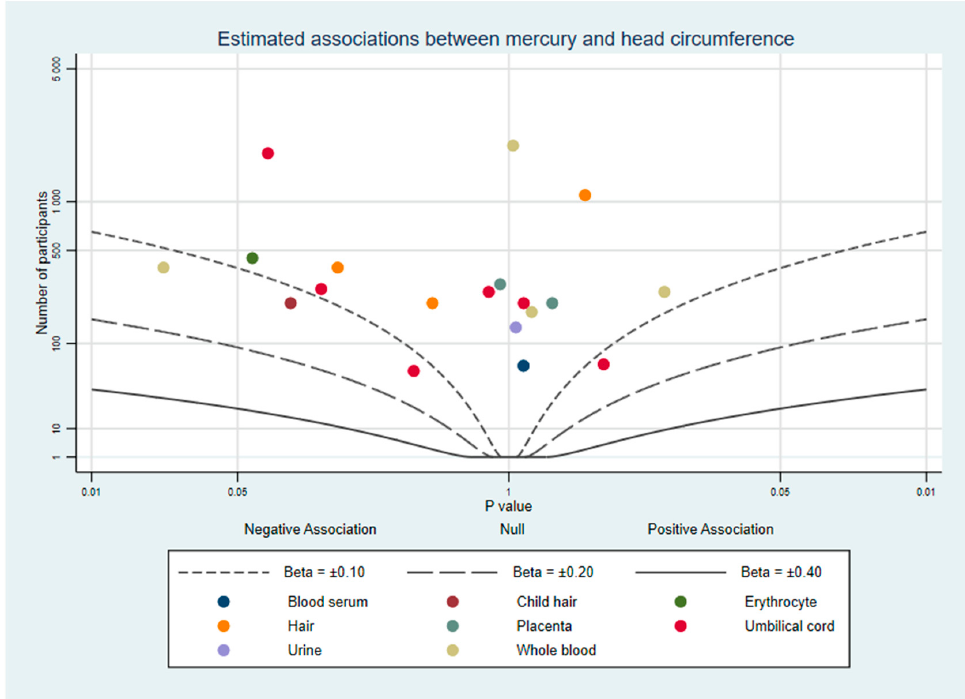
Figure 5. Albatross plot of the estimated effect of mercury exposure on head circumference. Mercury in blood samples taken pre-pregnancy [28], in the first trimester [41], and late pregnancy [29,30,48] were not found to be associated with head circumference at birth. Additionally, a US birth cohort reported an estimated association close to zero from third trimester urine mercury concentrations (3.63 cm per 10% increase in Hg, CI: − 66.8 to 74.1) [27]. In a UK cohort sub-group analysis investigated fish eaters (0.0 cm per µ g/L, CI: − 0.05 to 0.05) and non-fish eaters ( − 0.05 cm per µ g/L, CI: − 0.24 to 0.15), neither